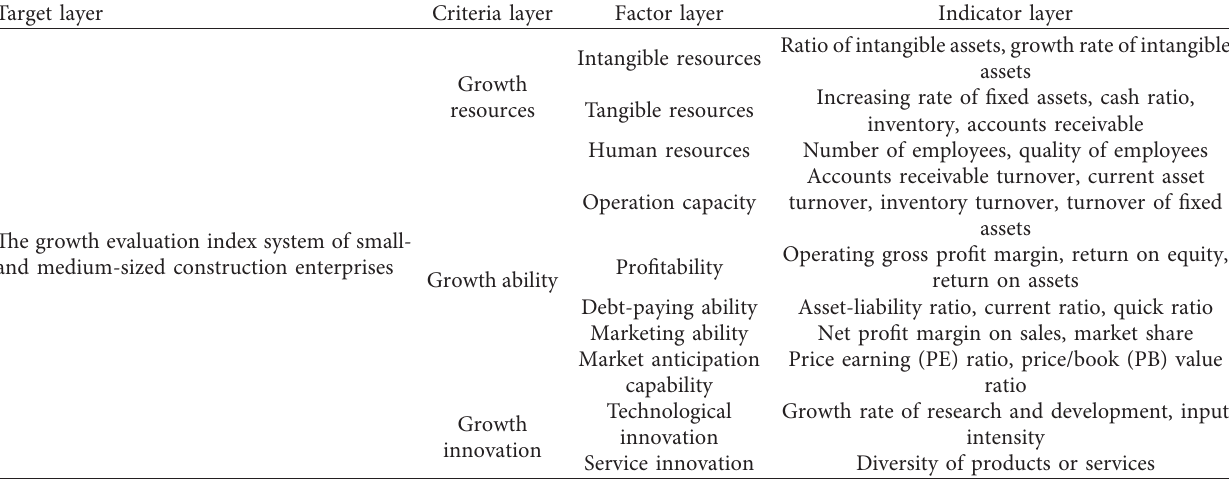
Table 1: The growth evaluation index system of small- and medium-sized construction